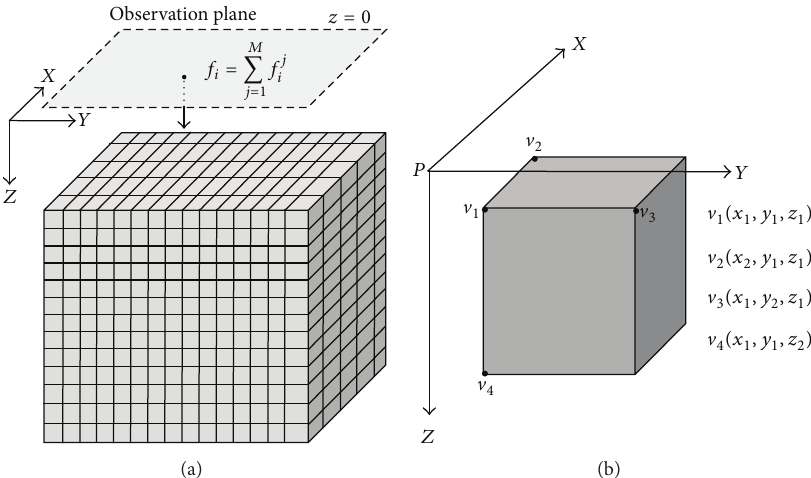
Figure 1: (a) Discretized media formed by 𝑀 rectangular prisms and the vertical component of the gravity response calculated over an observation point at the surface observation plane 𝑍 = 0 and (b) prismatic body located in a right rectangular coordinate system. 𝑃 is the observation point, where the gravity response is computed.